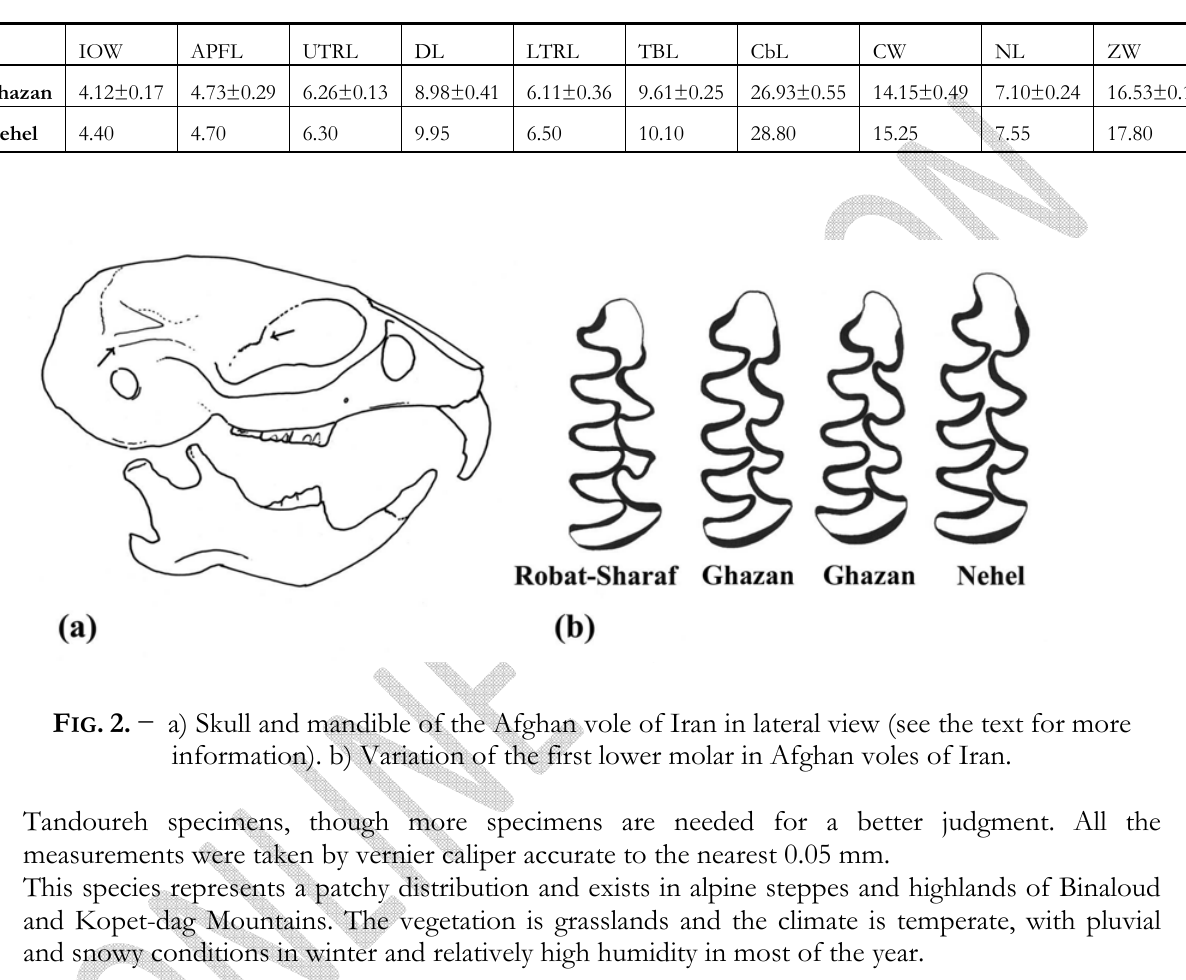
_ Skull measurements of Blanfordimys afghanus (in mm) for eight adult specimens from T ABLE 1. Ghazan in Tandoureh National Park (Mean ± SD), and the single specimen of Nehel, Zoshk. IOW- interorbital width; APFL- anterior palatine foramen length; UTRL- upper tooth row length; DL- diastema length ; LTRL- lower tooth row length; TBL- tympanic bulla length; CbL- condylobasal length; CW- cranium width; NL- nasal length; ZW- zygomatic width.